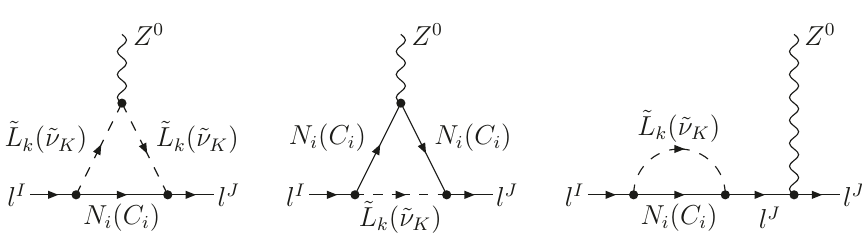
Figure 2 . One-loop supersymmetric contributions to the LFV e(cid:11)ective lepton- Z 0 interaction (the mirror-re(cid:13)ected self-energy diagram not